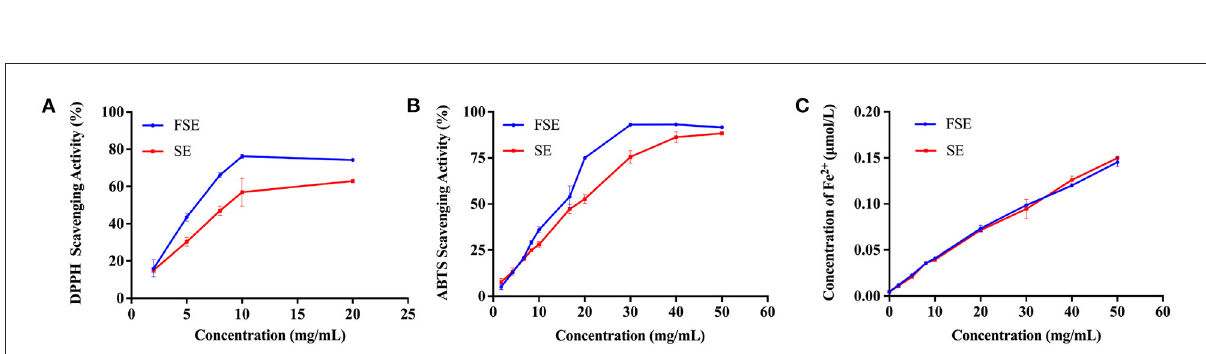
FIGURE4 Antioxidant capacity of 80% methanol extracts of soymilk and fermented soymilk. (A) DPPH free radical scavenging ability; (B) Radical scavenging ability of ABTS; (C) Iron reduction capacity. FSE: 80% methanol extract of fermented soymilk, SE: 80% methanol extract of soymilk.